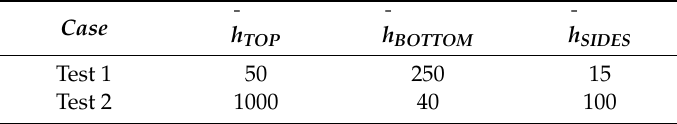
Table 6. Heat transfer coe ffi cients definition (W / (m 2